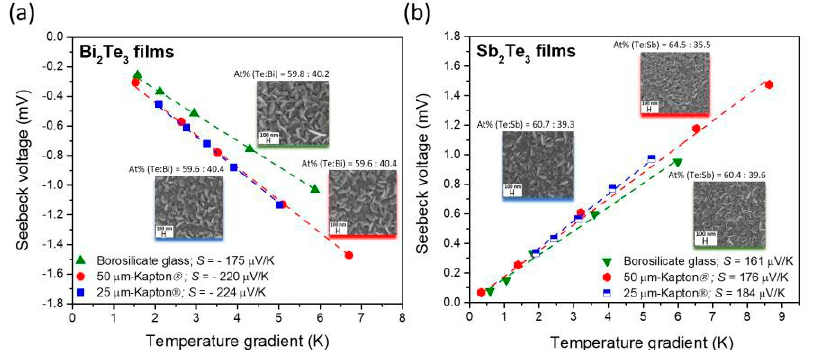
Figure 1. Seebeck voltage measured as a function of the induced temperature gradient for ( a ) Bi 2 Te 3 and ( b ) Sb 2 Te 3 films deposited on the three substrates. S values calculated from the slope are included. Surface morphology of all films are shown, with corresponding chemical composition of the